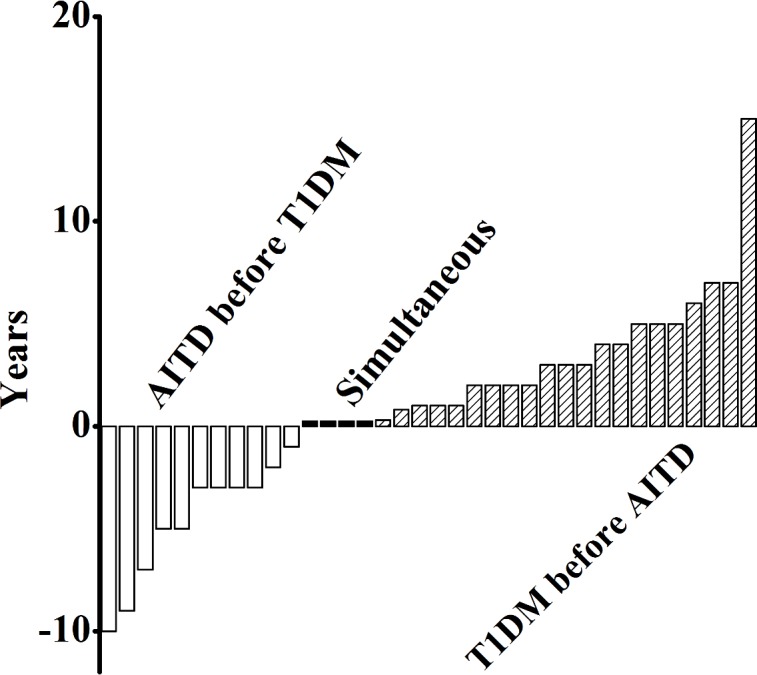
The interval from the onset of T1D to the onset of AITD or vise versus in APS3v patients.The open, closed, and shaded bars respectively represent the individual patients who developed AITD before, simultaneous or after T1D diagnosis.